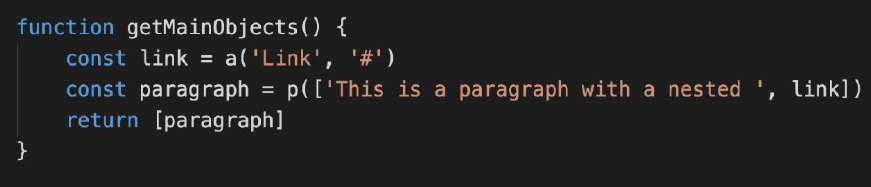
Figure 6. Implementation of the getMainObjects function to create a paragraph with a nested link